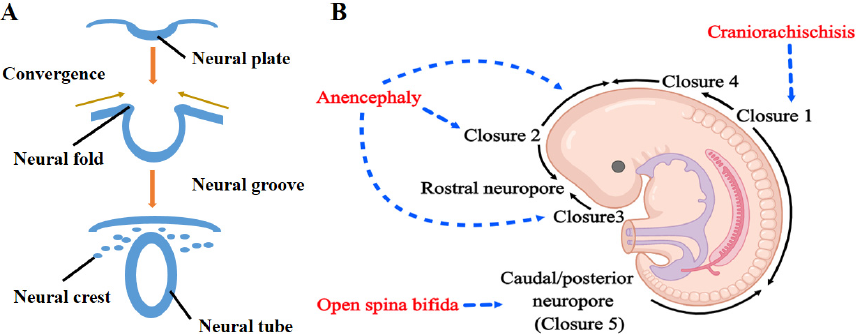
Figure 1. The schematic diagram of neural tube formation and the development of NTDs in human. ( A ) Diagram of neural tube formation. Neural plate bends to create the neural folds, which elevate towards the dorsal midline, and finally fuse to complete the formation of neural tube; ( B ) diagram of neural tube closure and the development of NTDs in human embryos (created with https://image.medpeer.cn, accessed on 9 January 2023). Neural tube closure is a discontinuous process initiated at closure 1, which may occur in the mid-cervical region. Failure of closure 1 results in craniorachischisis. Closure also initiates at Closure 3 (the rostral extremity of the forebrain). Fusion from the initial sites spreads bi-directionally into the cranial region and along the spinal region, finally completed by closure of the anterior and posterior neuropores (shown by black arrows). Failure of Closure 2 or Closure 3 results in anencephaly. Open spina bifida results from failure of posterior neuropore (Closure 5) closure.